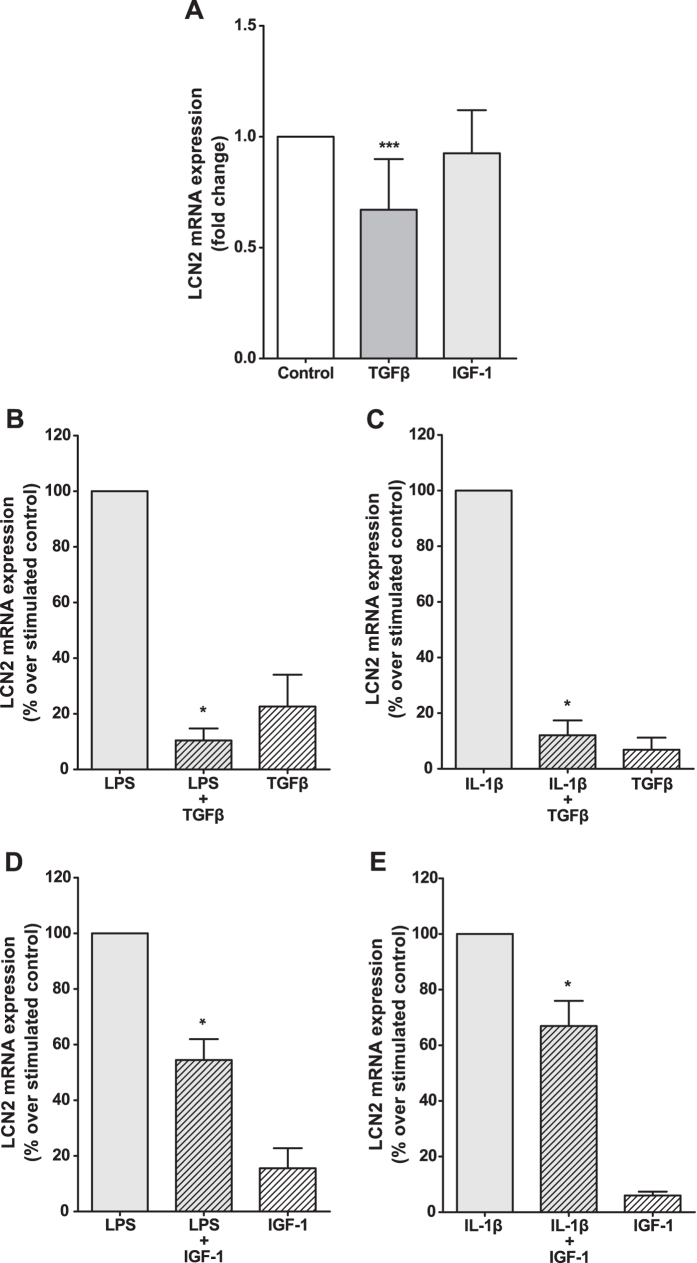
Effect of anabolic factors on LCN2 expression in primary human osteoblasts.Human osteoblasts were grown until confluence. After overnight culture in 1% FBS, cells were stimulated with 10 ng/ml TGF-β1 or 100 ng/ml IGF-1 alone (A) or in combination with 1 μg/ml LPS (B,D) or 1 ng/ml IL-1β (C,D) for 48 h. Then, LCN2 mRNA expression was measured by real-time PCR. The results are presented as the mean ± SEM of at least four independent experiments and expressed as a fold-change over the control (A) or as the percentage over the stimulated control (B–E) (*p < 0.05, ***p < 0.001).